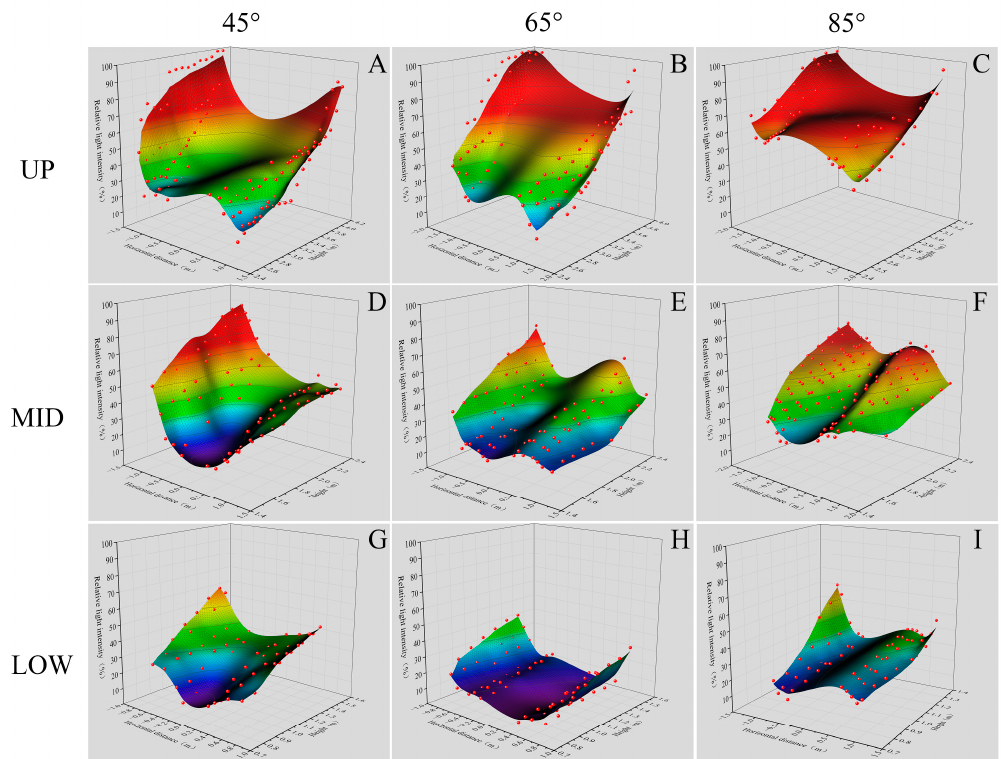
Figure 6. Three-dimensional distribution of the relative light intensity in the canopy of the peach trees at the end of the crown formation. UP (( A ): 45 ◦ ; ( B ): 65 ◦ ; ( C ): 85 ◦ ); MID (( D ): 45 ◦ ; ( E ): 65 ◦ ; trees at the end of the crown formation. UP (( A ): 45°; ( B ): 65°; ( C ): 85°); MID (( D ): 45°; ( E ): 65°; ( F ): 85°); LOW (( G ): 45°; ( H ): 65°; ( I ): 85°). ( F ): 85 ◦ ); LOW (( G ): 45 ◦ ; ( H ): 65 ◦ ; ( I ): 85 ◦ Table 4. The proportion of light intensity under the di ff erent main branch opening angles in the fi nal stage of crown formation (%). Angle Location